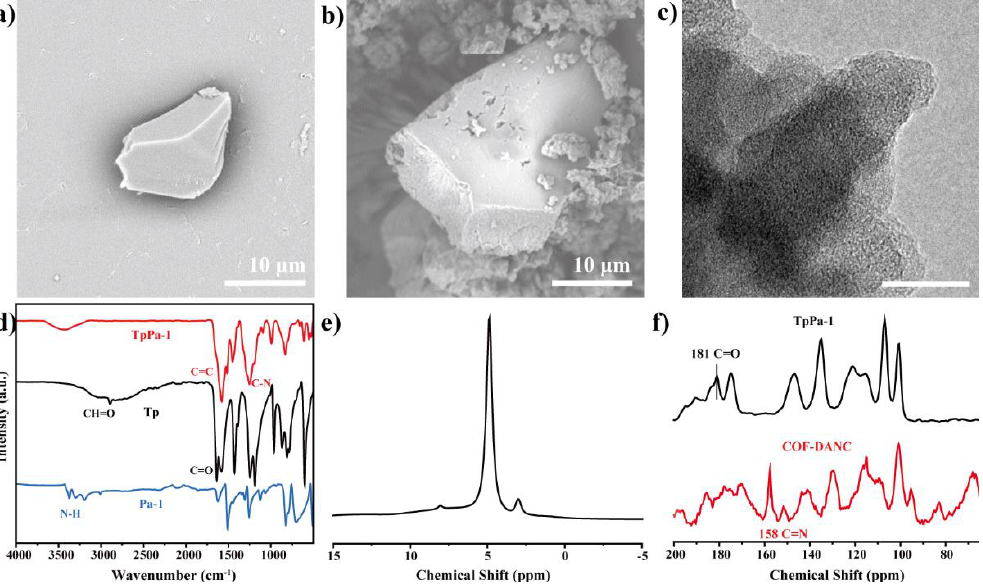
Figure 4. Scanning electron microscope ( a , b ) and TEM image ( c ) of TpPa-1; FTIR image ( d ) of TpPa-1 and its monomer; 1 H NMR ( e ) of COF-TpPa-1; 13 C NMR ( f ) of COF-TpPa-1 and TpPa-1-DANC.